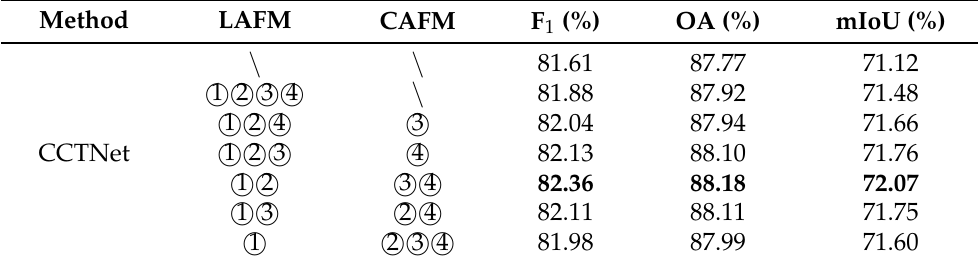
Table 4. Experiments on the location settings of the LAFM and the CAFM.